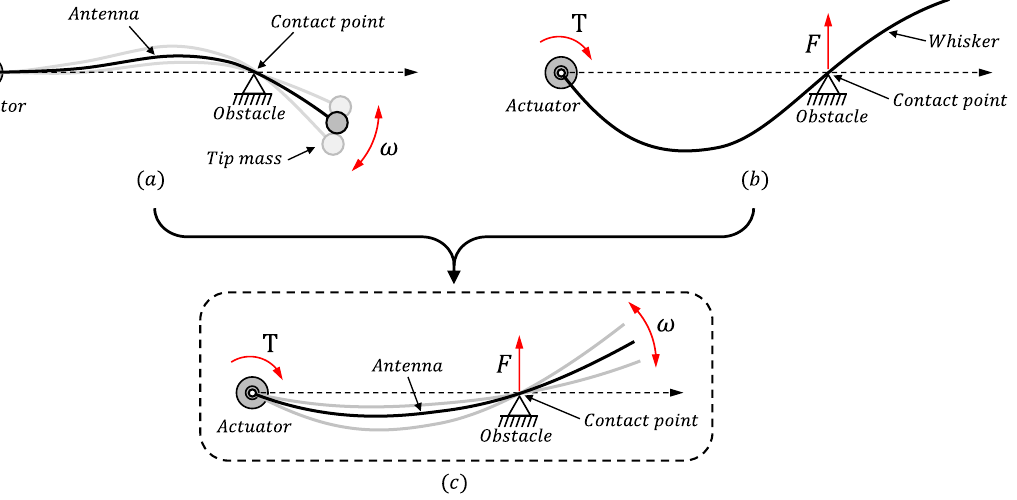
Figure 1. Different methodologies used in: ( a ) [22], ( b ) [23]; and ( c ) the present